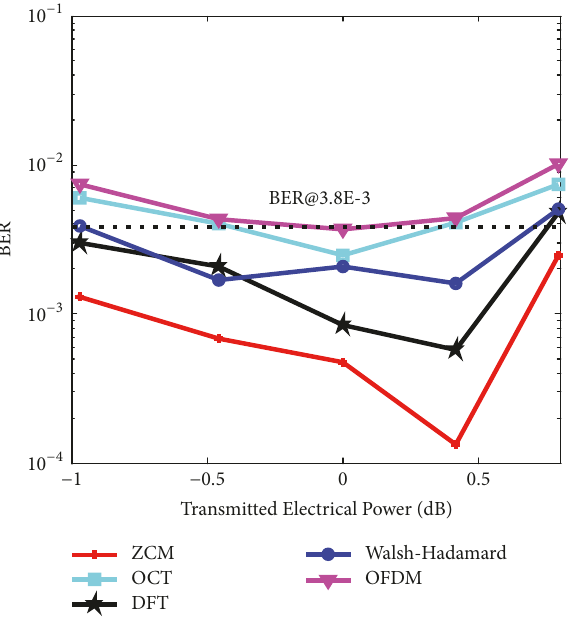
Figure 6: BER versus transmitted electrical